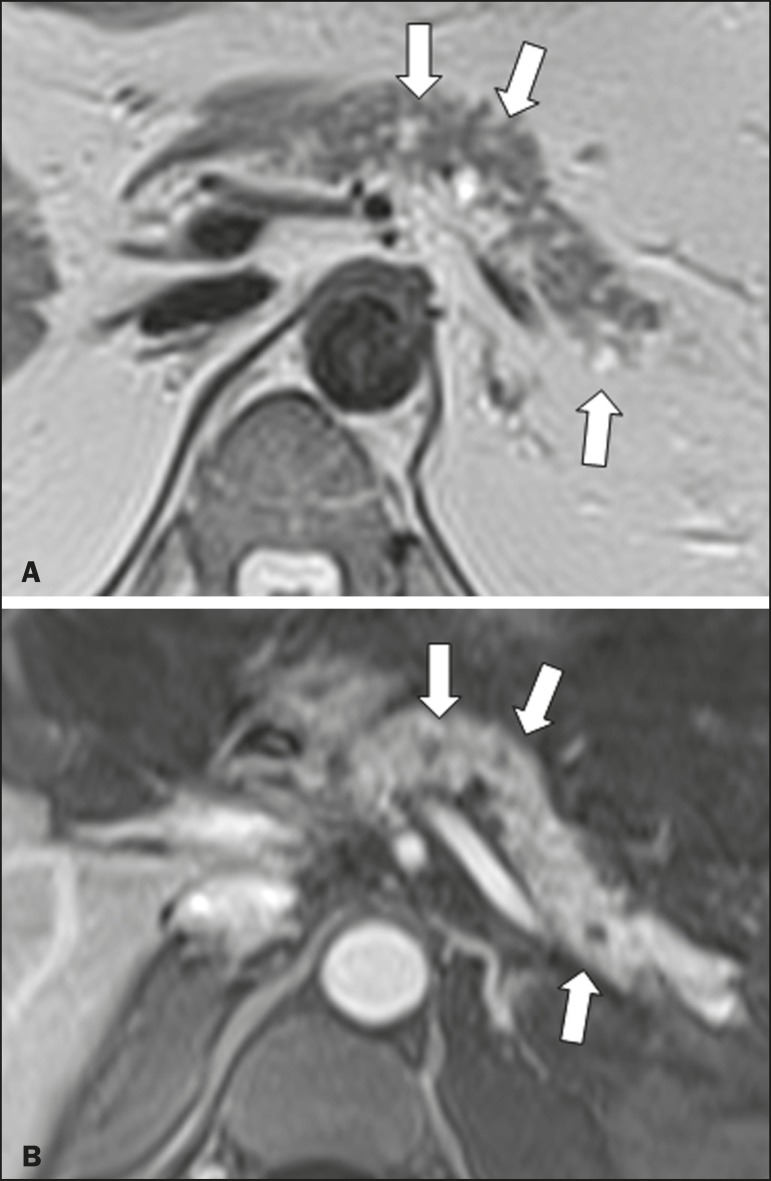
MRI scans. T2-weighted sequence (A) and contrast-enhanced
T1-weighted sequence (B), showing small cystic lesions in
contact with the pancreatic duct (arrows), with aspects characteristic
of intraductal mucinproducing tumors.